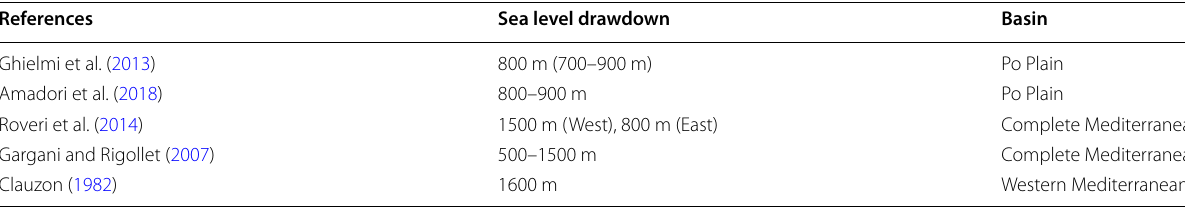
Table 1 Estimates of sea level drop during